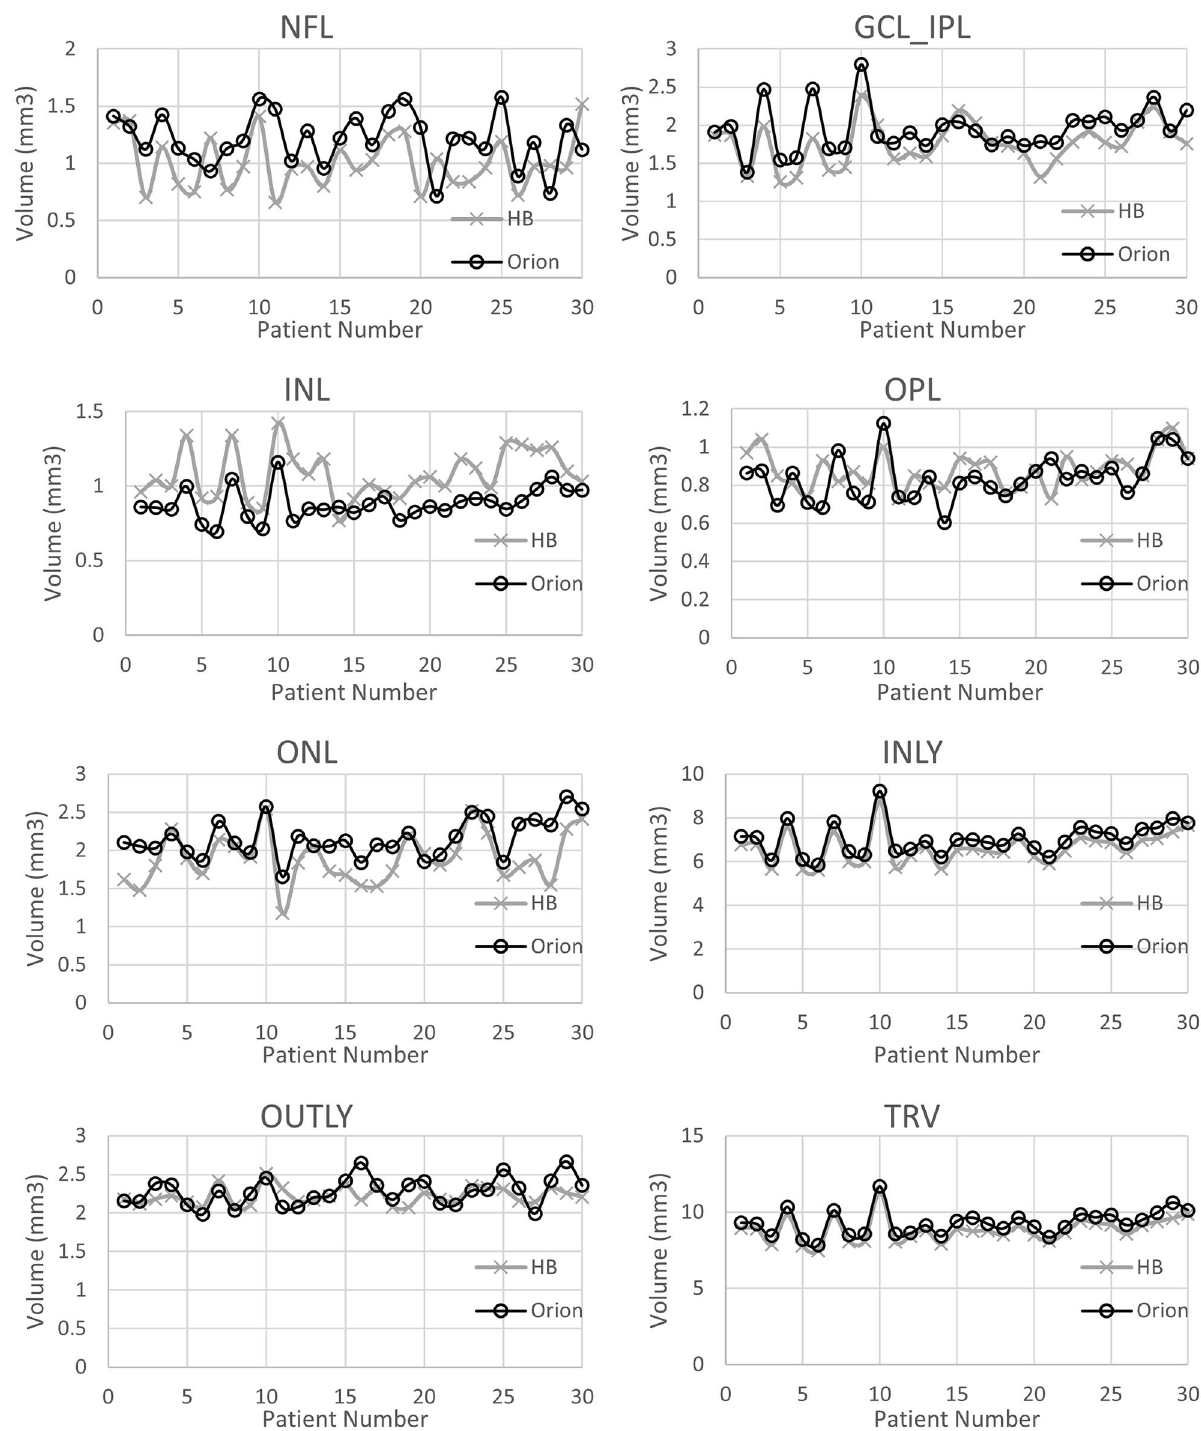
Figure 4. Comparison of retinal layer volumes between proprietary and cross-platform softwares in eyes with